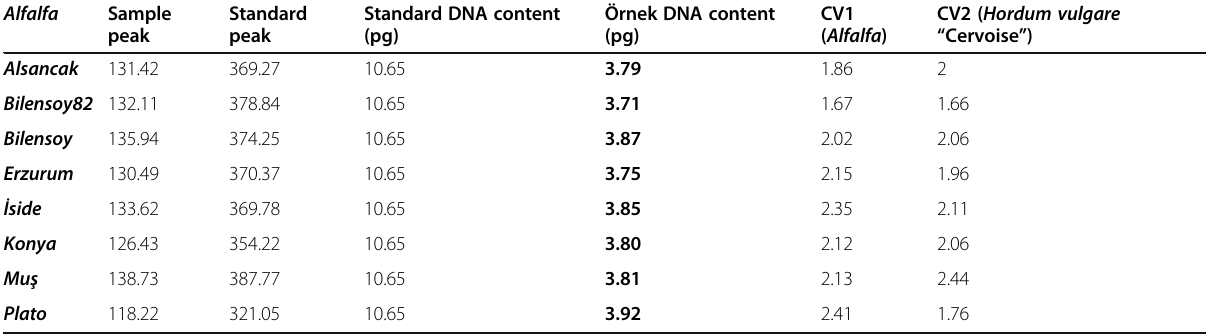
Table 2 Nuclear DNA content of alfalfa varieties Alfalfa Sample Standard peak peak